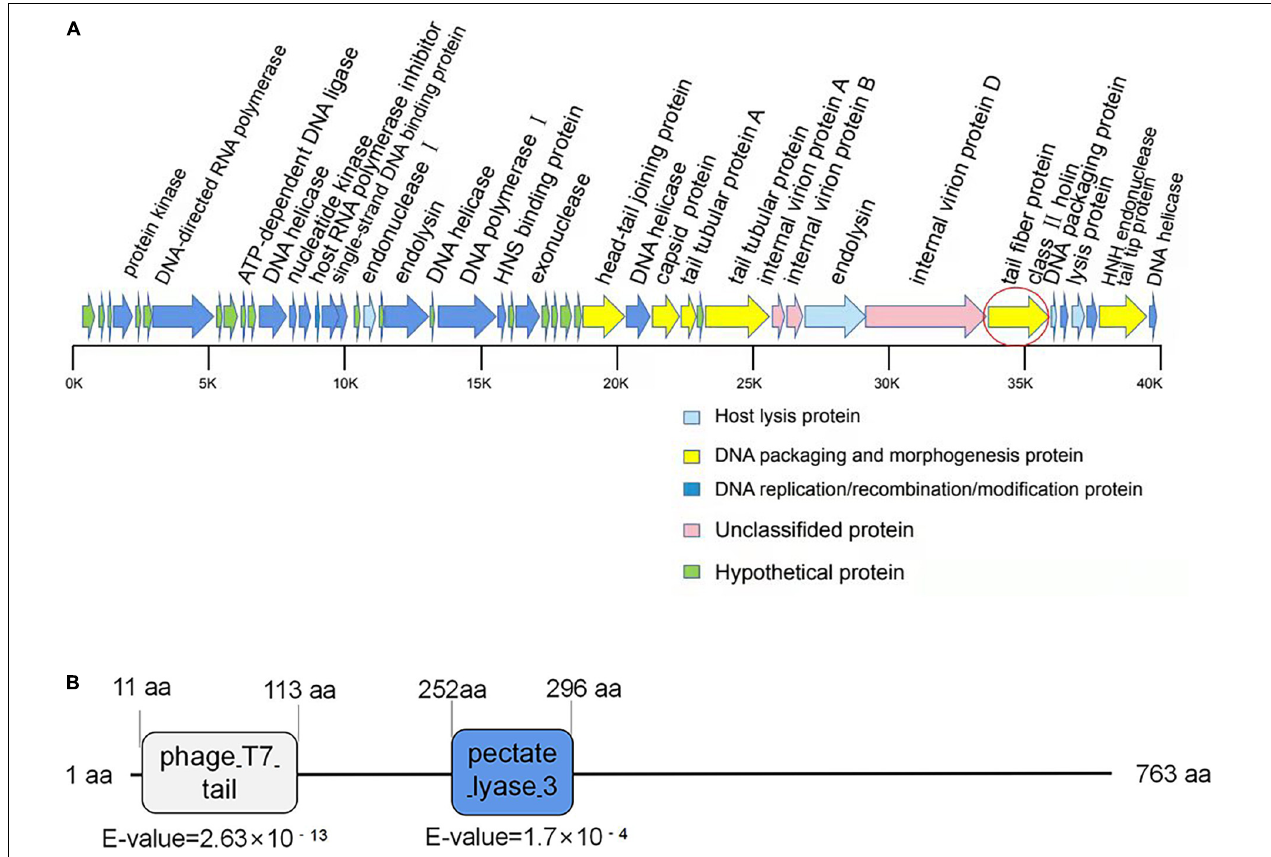
FIGURE 2 | Bioinformatic analysis of the genome of phage SH-KP156570. (A) Gene map of the phage SH-KP156570. Predicted ORFs were shown. The linear map was based on nucleotide sequences of the whole genome. The red circle denoted ORF41, the gene encoding the putative polysaccharide depolymerase. (B) Bioinformatic analysis of the putative depolymerase of the phage SH-KP156570. The result showed a 763 aa protein with two conserved domains: phage T7 (residue 11–113) and pectate lyase domain (residue 252–296) by using BLASTp and HHpred. ORF41 was determined and identified as protein